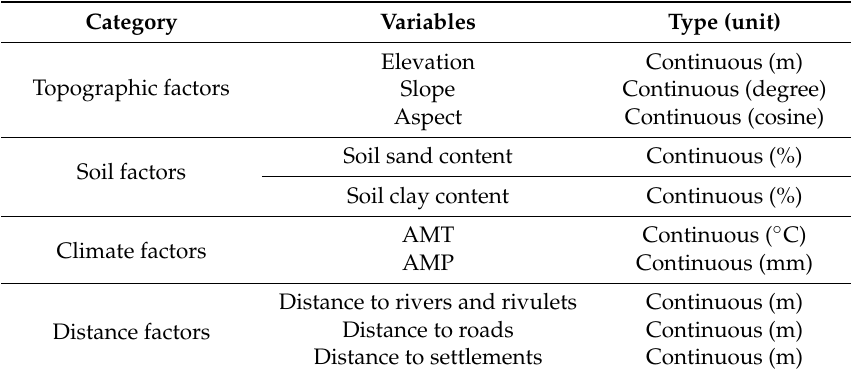
Table 2. Factors used to describe farmland